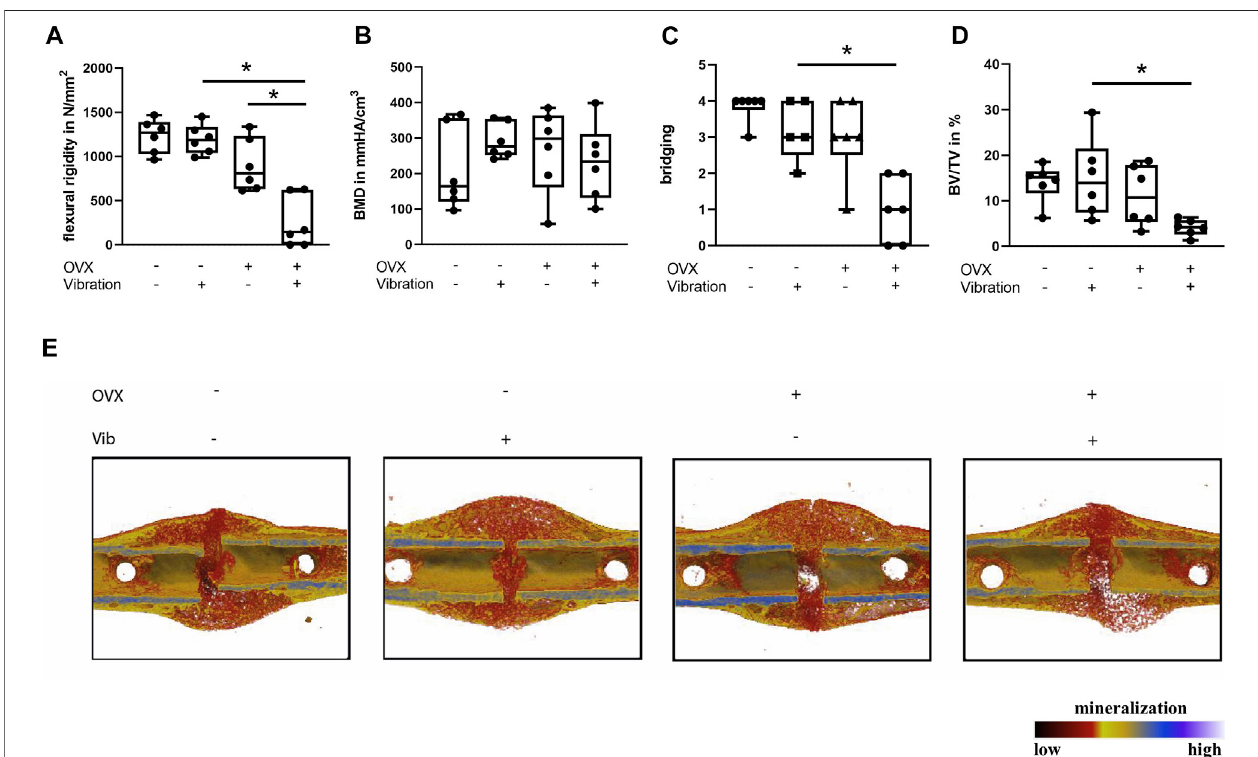
FIGURE4| In fl uenceofLMHFV onfracturehealinginER α fl / fl ;Runx2Cre mice onday 21.Biomechanicaltestingand μ CTanalysis. (A) Bendingstiffness ofthefracture callus. (B) Bone mineral density ofthe fracture gap. (C) Bony bridging of the fracture gap evaluated in two perpendicular planes. (D) Relative bone volume (BV/TV) in the fracture gap. (E) Representative μ CTimages from the fractured femurs. Red indicates weakly mineralized bone whereas yellow and light blue indicate highly mineralized bone. Data are shown as box-and-whisker plots (with median and interquartile range) from max. to min., showing all data points. *indicates signi fi cant effects with p ≤